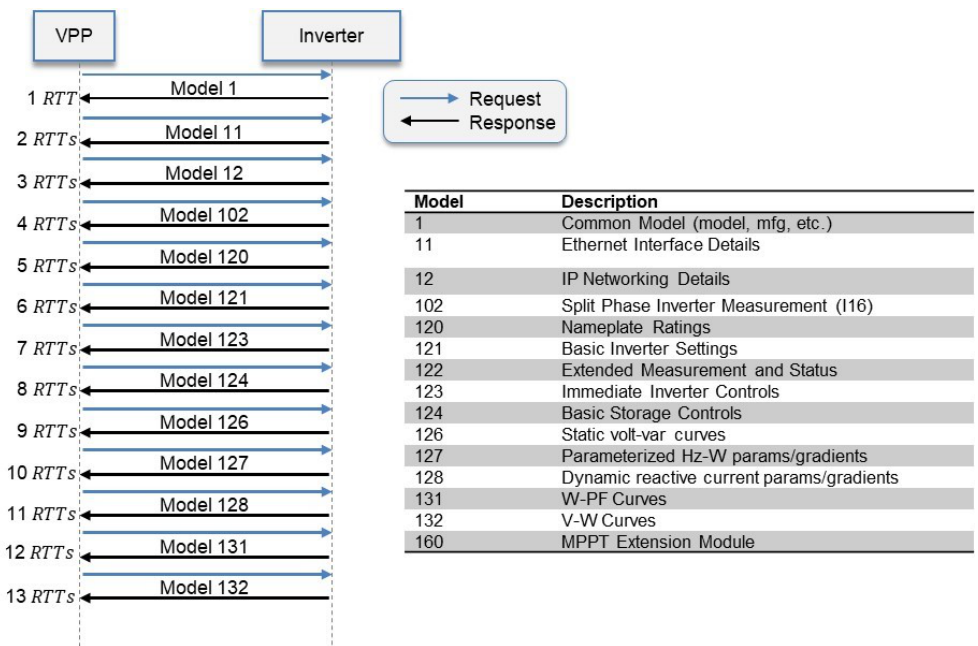
Figure 9. Information exchange associated with SMA scan. Model descriptions are provided in the embedded table.